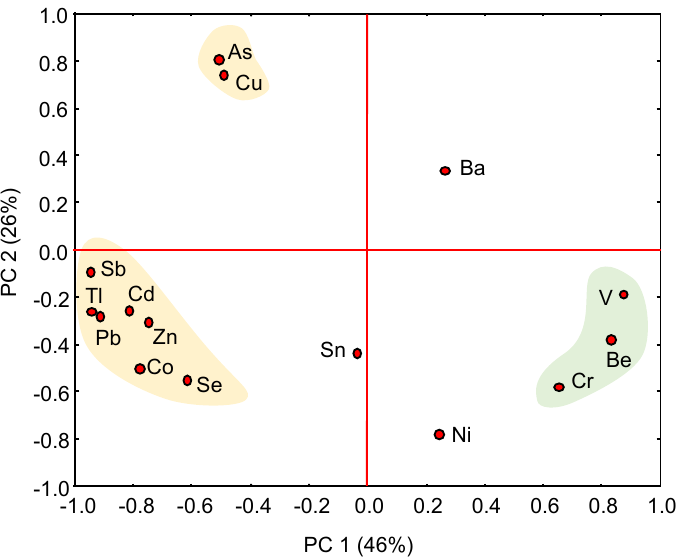
Figure 8. PCA diagram of the total concentration of trace elements. Several clusters are apparent on the projection of the scores on the first two principal components (PC1 and PC2), which explain 72% of total variance.